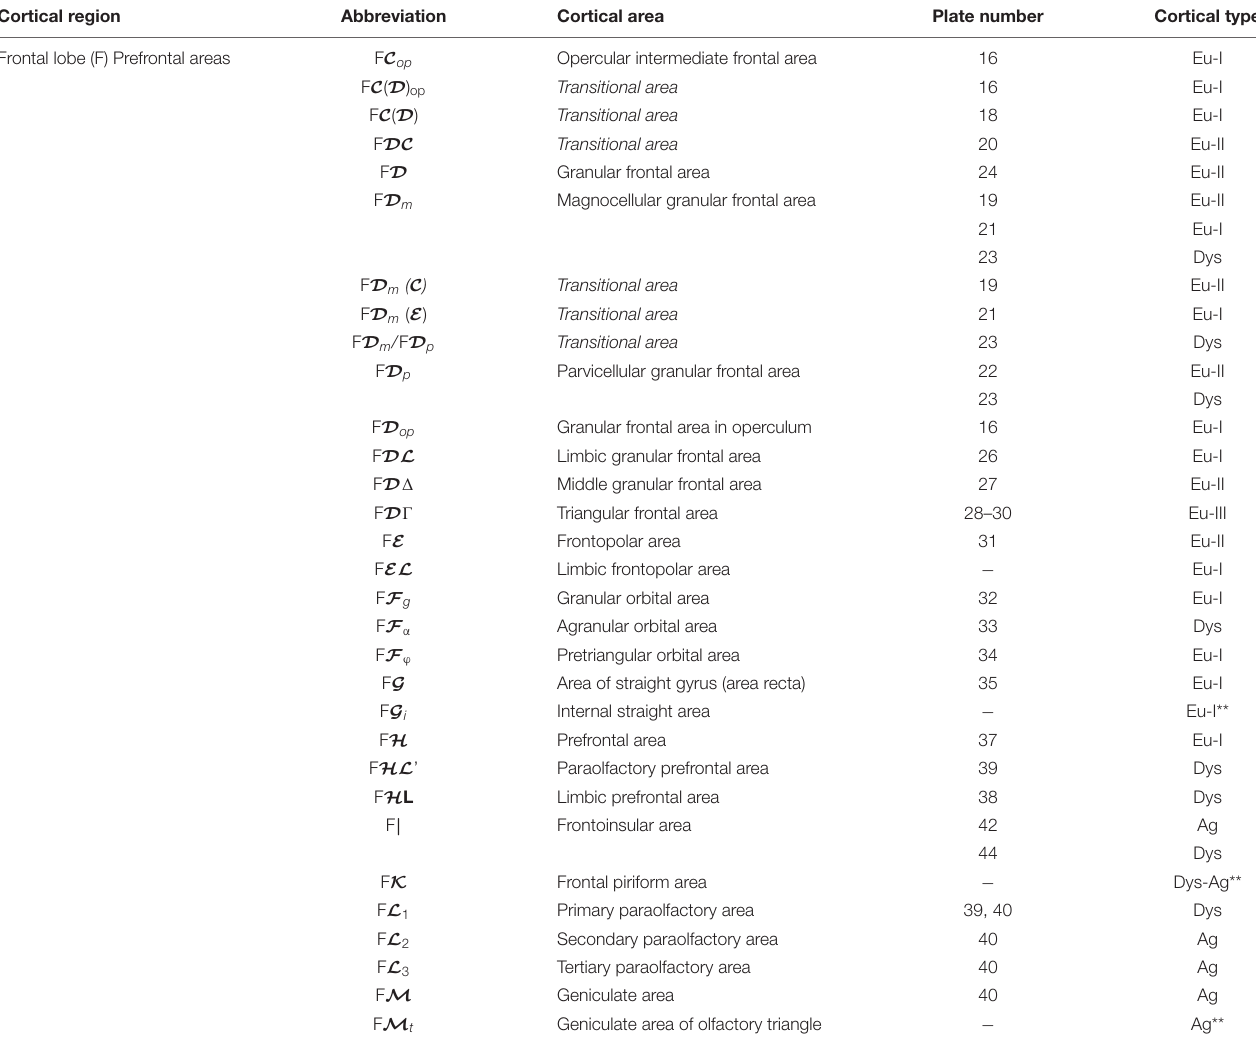
TABLE 5 | Areas in the human cerebral cortex according to von Economo and Koskinas (1925/2008) and their corresponding types: Frontal lobe, prefrontal areas. Cortical